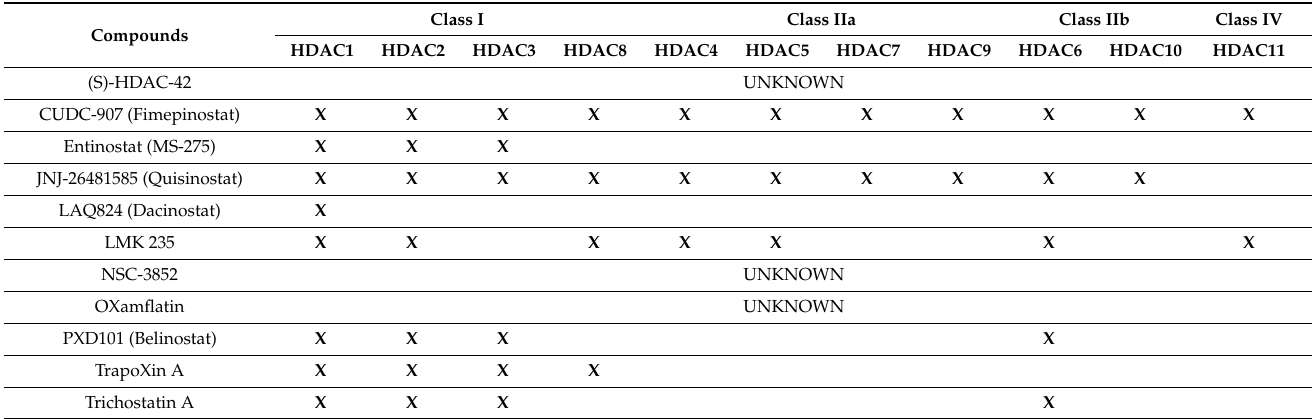
Table 4. Known HDAC targets for HDAC inhibitors that showed efficacy in all